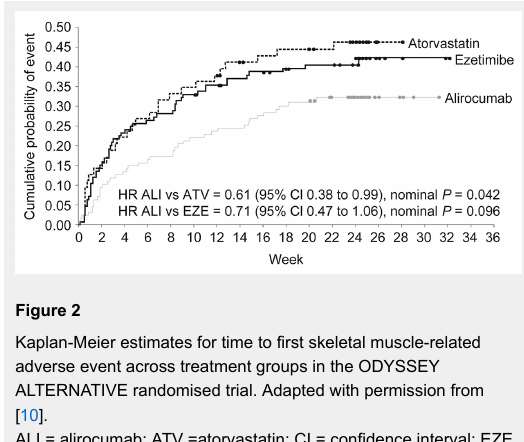
Kaplan-Meier estimates for time to first skeletal muscle-related adverse event across treatment groups in the ODYSSEY ALTERNATIVE randomised trial. Adapted with permission from [10]. ALI = alirocumab; ATV =atorvastatin; CI = confidence interval; EZE = ezetimibe; HR = hazard